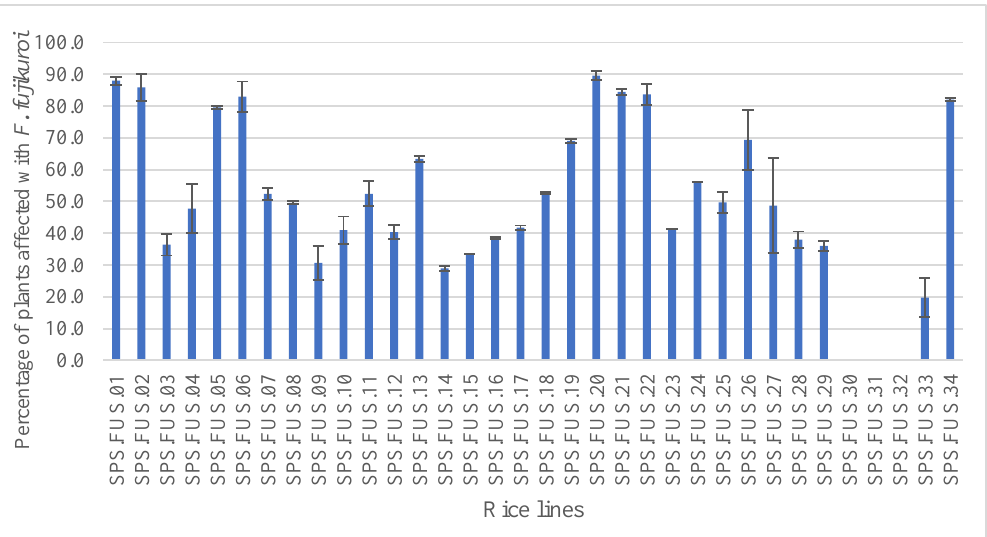
Figure 1. Percentage of plants grown in the greenhouse, affected with F. fujikuroi . The values are the means ± standard deviations (ANOVA, Tukey test, p ≤ 0.05).